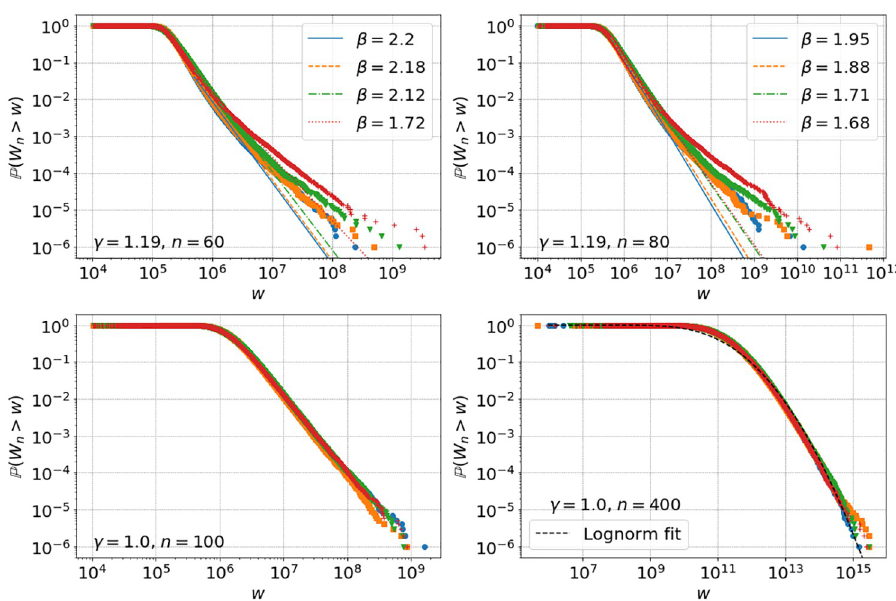
Fig 8. Top left and right: empirical tails for simulation (3) with N = 10 6 agents, residual savings S ( k , c , l , s ) with fitted parameters (12) but with γ = 1.19 for the four initial conditions with colours and symbols as in I.1 - I.4 , replacement mechanism R.1 and power law fits with exponents β . Bottom left and right: empirical tails for simulations as in top row, but with γ = 1, S